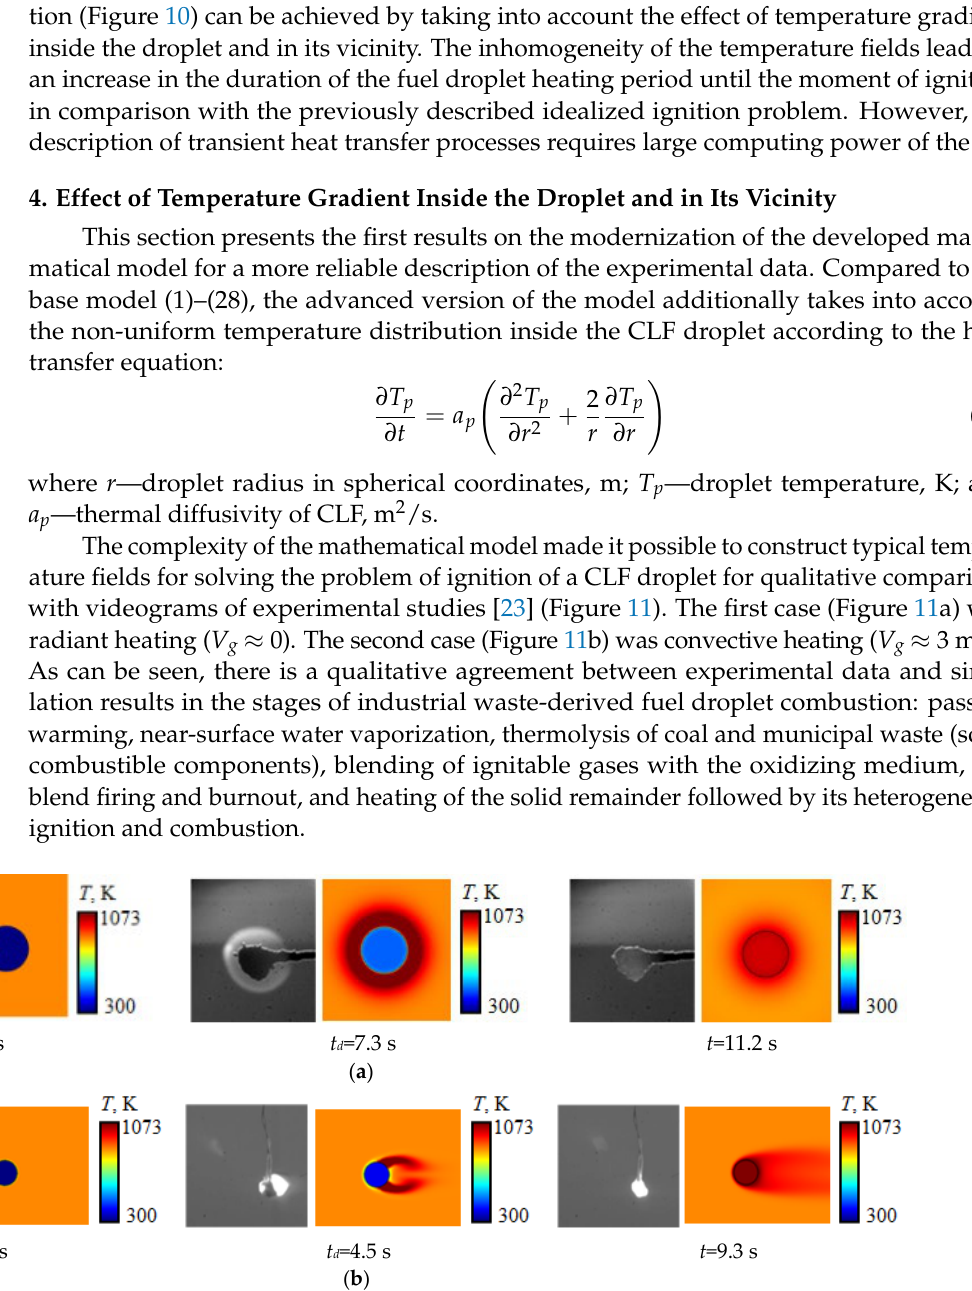
V g =3 m/s ( a ) ( b ) Figure 12. Ignition-delay times vs. heating source temperature for CLF composition No. 5 (FC 90% + cardboard 10%) at: ( a ) V g = 0; ( b ) V g = 3 m/s. It should be noted that when the non-uniform temperature distribution inside a sin- gle CLF droplet and in its vicinity is taken into account, the PC calculation times increase by a factor of 5–10. On the scale of the steam boiler, there will be an exponential increase in the PC calculation times. The relatively simple modernization performed on the mathematical model, on the one hand, leads to a satisfactory agreement between the results of numerical simulation and experimental data, but, on the other hand, requires large computing power. The most rational approach in practical applications is the devel- opment of a mathematical model with maximum simplifications but with acceptable re- producibility of experimental data. 5. Conclusions Based on results of previous experimental studies, a mathematical model was devel- oped for the ignition and combustion of a single composite liquid fuel droplet (a mixture 700